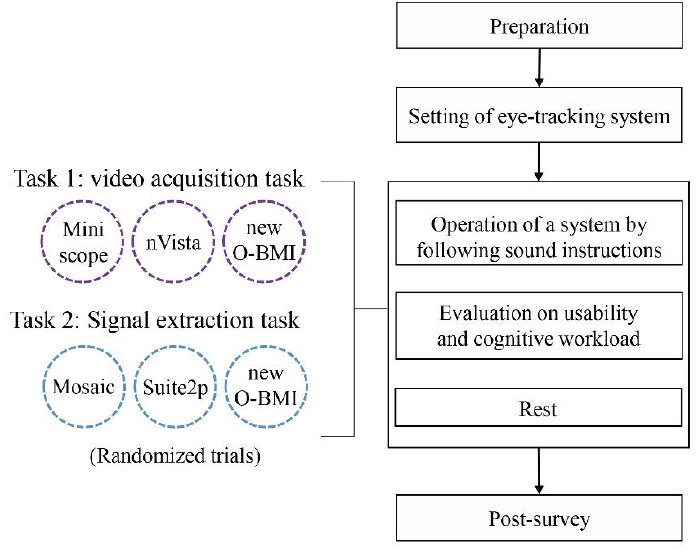
Figure 8. Experiment procedure of O-BMI usability testing.